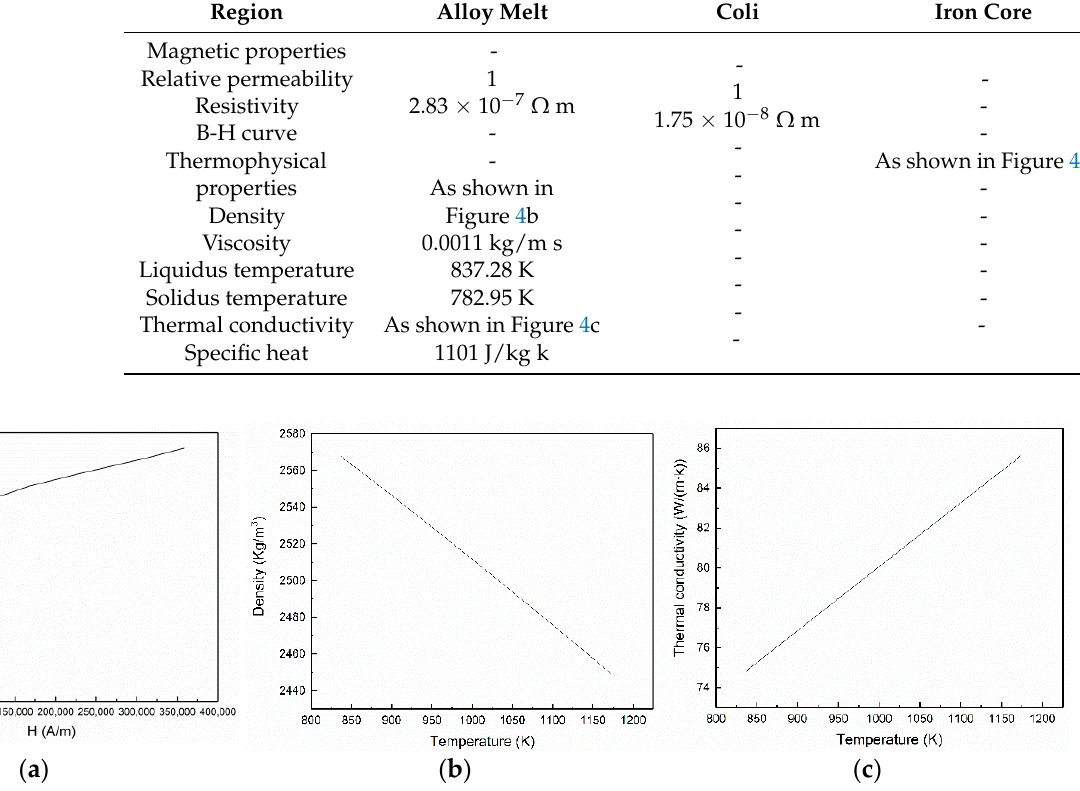
Figure 4. ( a ) B-H curve, ( b ) density and ( c ) thermal conductivity.